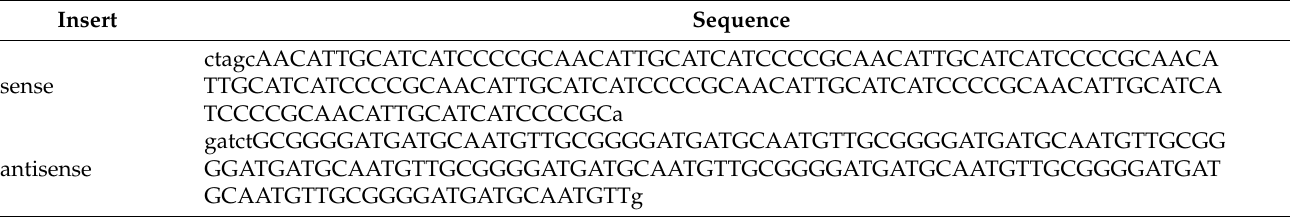
Table 3. Octamer transcription response element sequences for the construction of the pTR21F